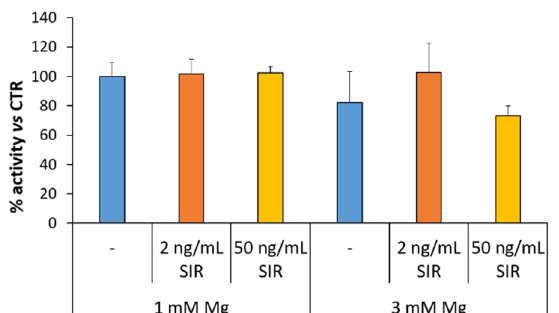
Figure 5. The effects of sirolimus and Mg on the response of rSMC to SNP. The cells were cultured in medium containing 1 or 3 mM Mg with or without sirolimus (2 and 50 ng/mL). After 72 h, the cells were treated with SNP for 30 min. cGMP was measured as described in the methods. Data are expressed as the mean ± standard deviation of three independent assays.